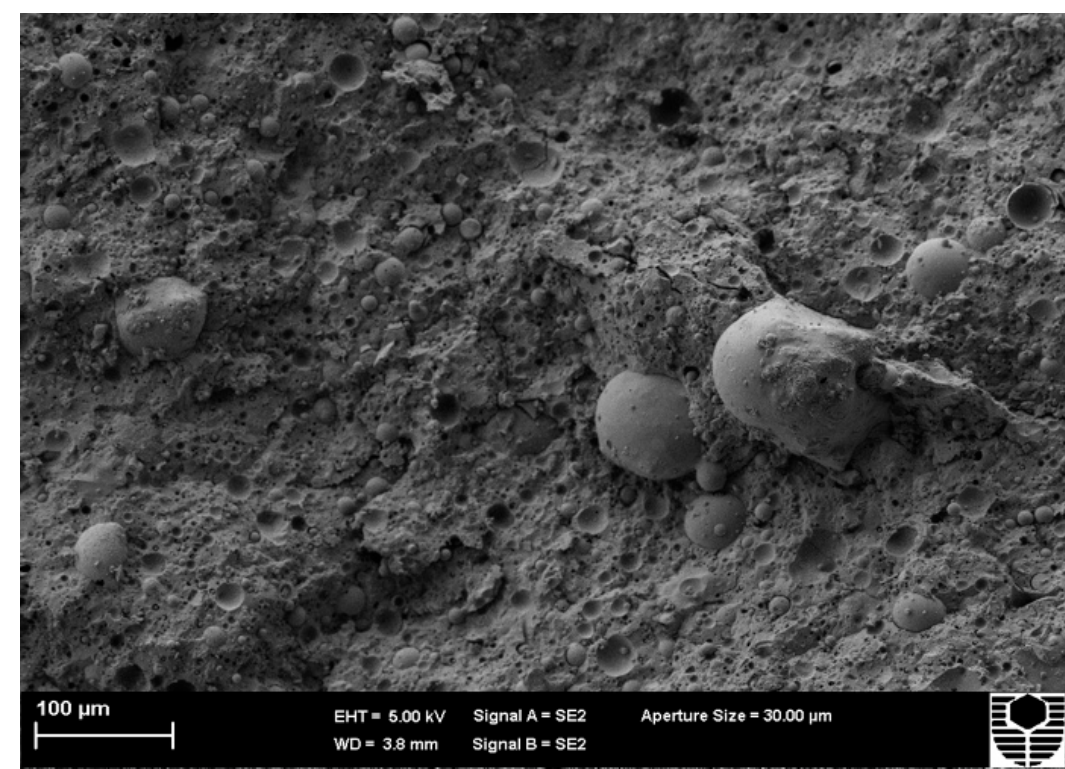
Figure 8. Microstructure of Mix 3 for FA-based geopolymer.